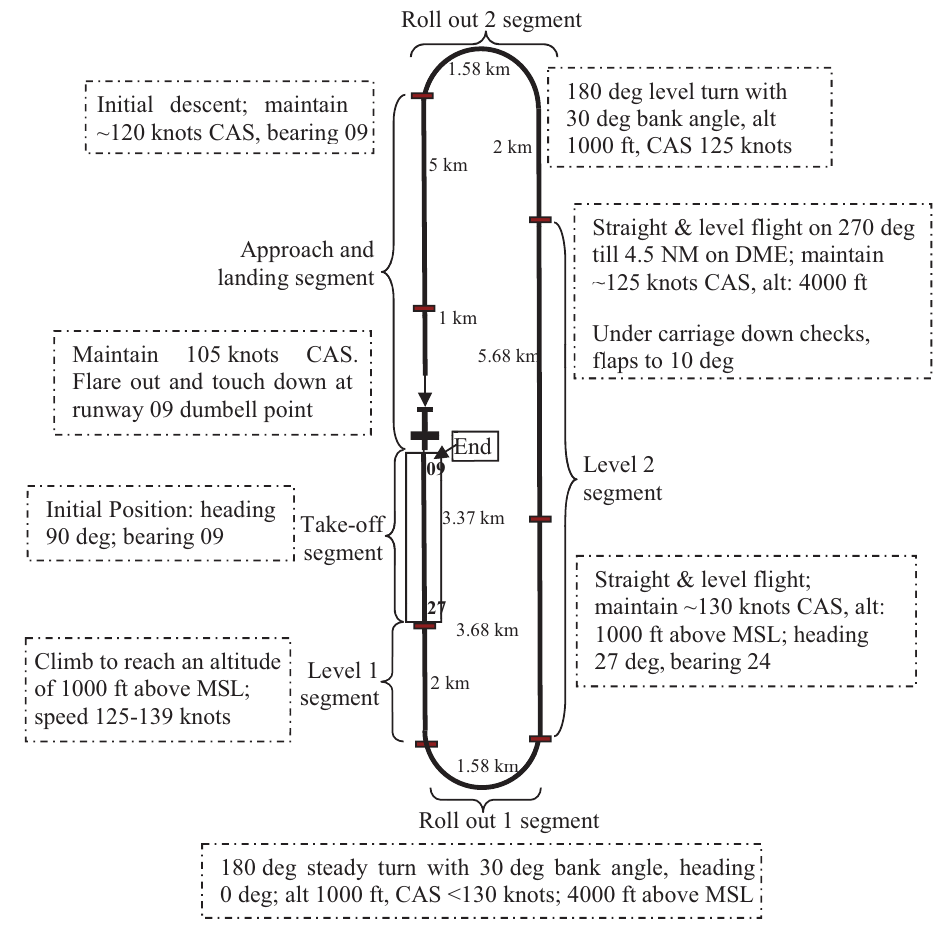
Figure 2. Flight